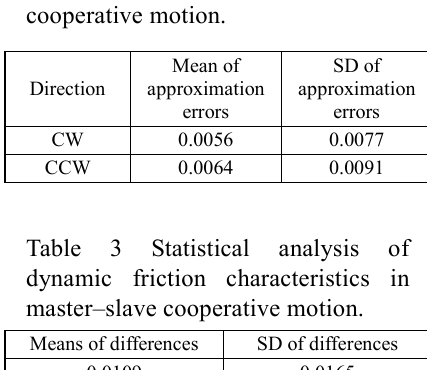
Table 2 Statistical analysis of stiffness characteristics